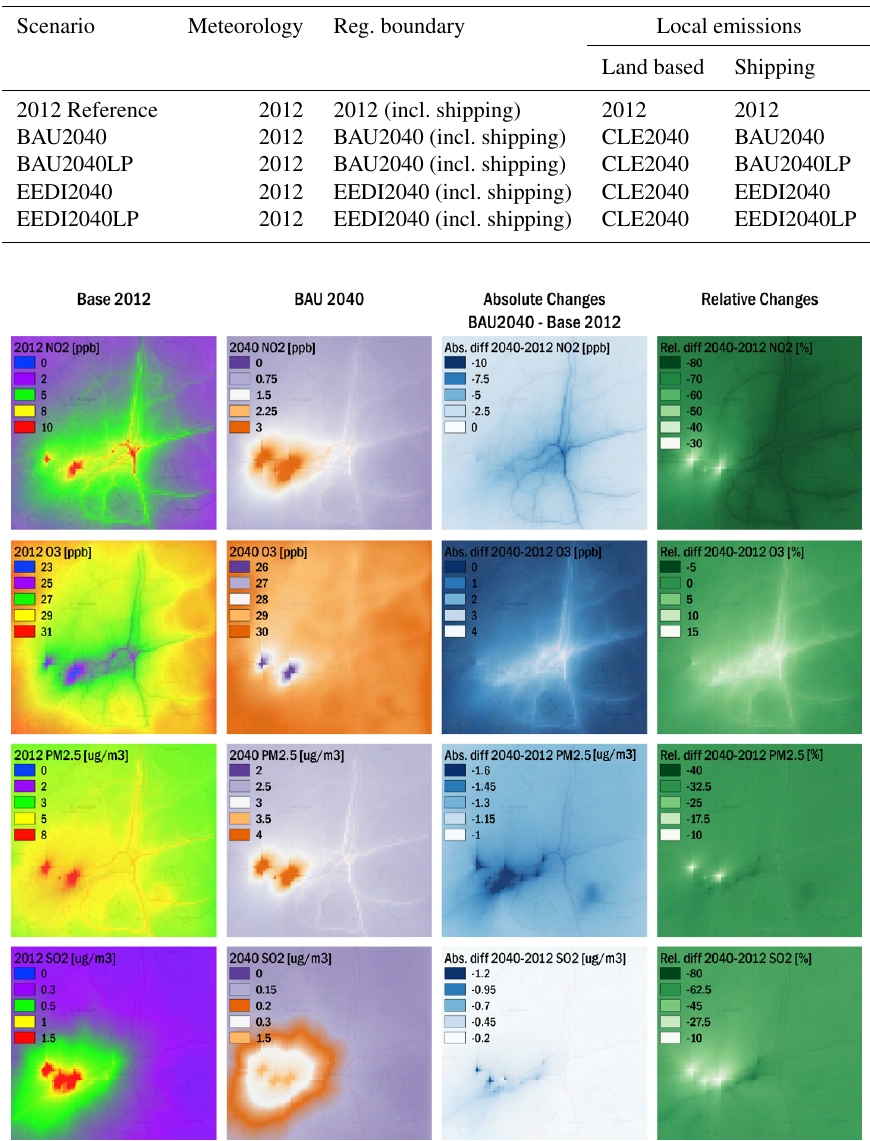
Figure 5. The total modelled present-day concentration for NO 2 , O 3 , PM 2 . 5 , and SO 2 (column 1), as well as the concentration in BAU2040 (column 2) and the difference between the present day and BAU2040 in absolute (column 3) and relative (column 4) values. ©OpenStreetMap contributors 2019. Distributed under a Creative Commons BY-SA